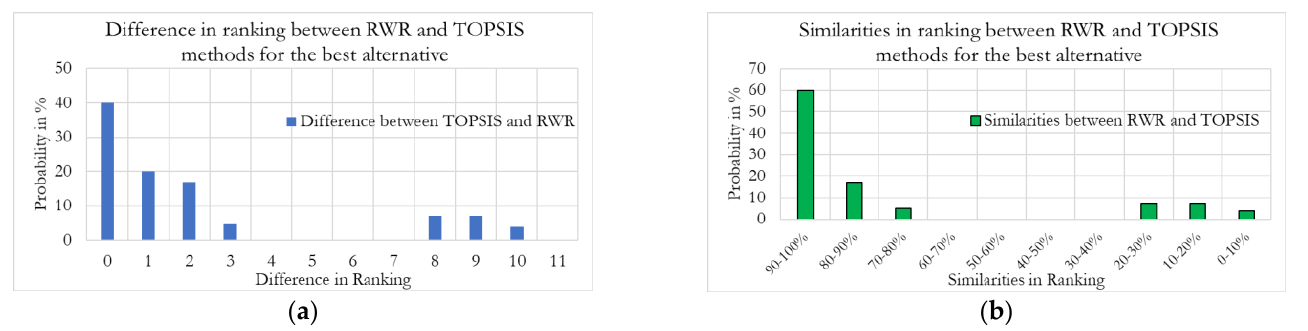
Figure 9. Difference and similarities in ranking between RWR and TOPSIS, ( a ) Difference in ranking between RWR and TOPSIS methods for the best alternative, ( b ) similarities in ranking between RWR and TOPSIS methods for the best alternative.